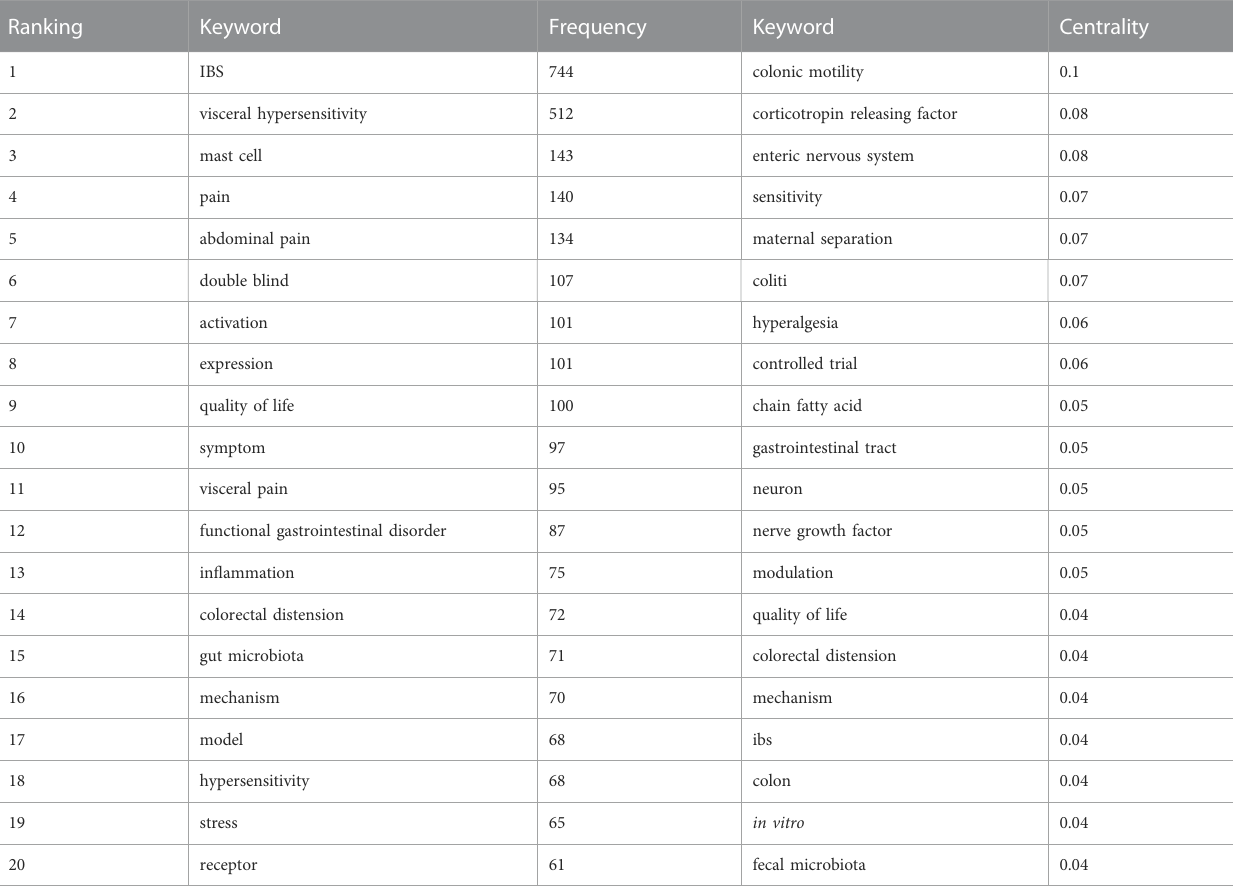
TABLE 4 Top 20 keywords in terms of frequency and